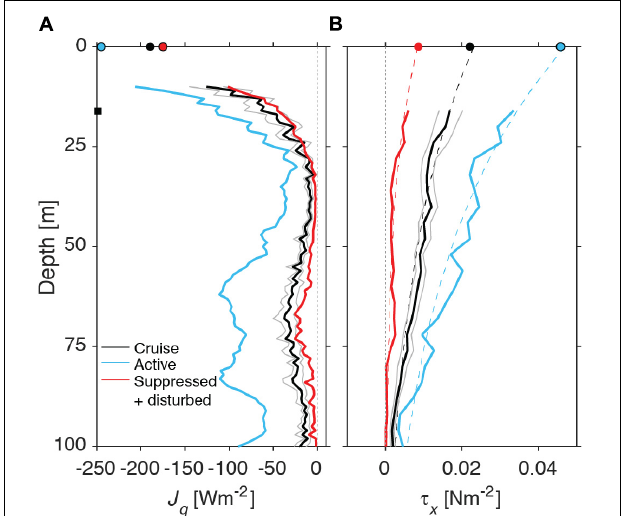
FIGURE 3 | Quantitative demonstration of turbulence fluxes assessed from turbulence profiling. Vertical profiles of the turbulent fluxes of heat (A) and momentum (B) derived from turbulence profiling measurements akin to those proposed for ArgoMix. In the legend, “active” refers to strong surface forcing; “suppressed” to weak surface forcing. Surface values of the fluxes are indicated by the dots at depth = 0. Measurements are from the equatorial Indian Ocean before (red) and during (blue) the passage of westerly wind bursts of the MJO. Subsurface fluxes co-vary with the forcing and asymptote to surface values, as they must [Source: adapted from Pujiana et al., 2018, Copyright 2018 American Meteorological Society (AMS). Reprinted with